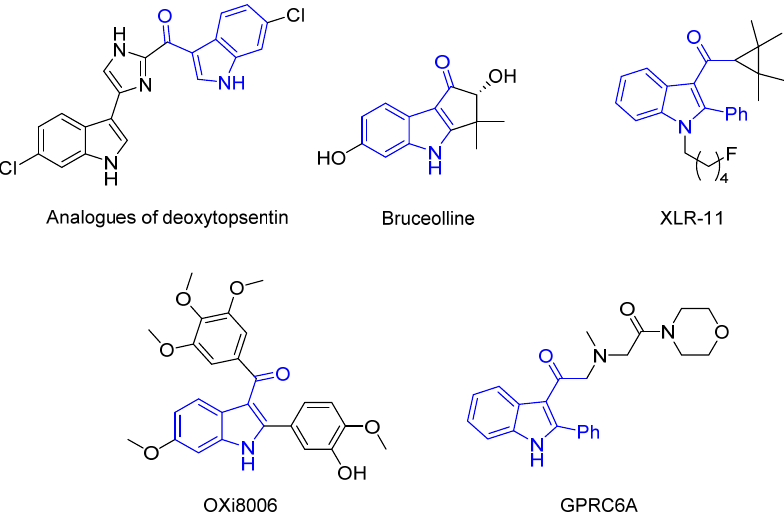
Figure 1. Bioactive products containing